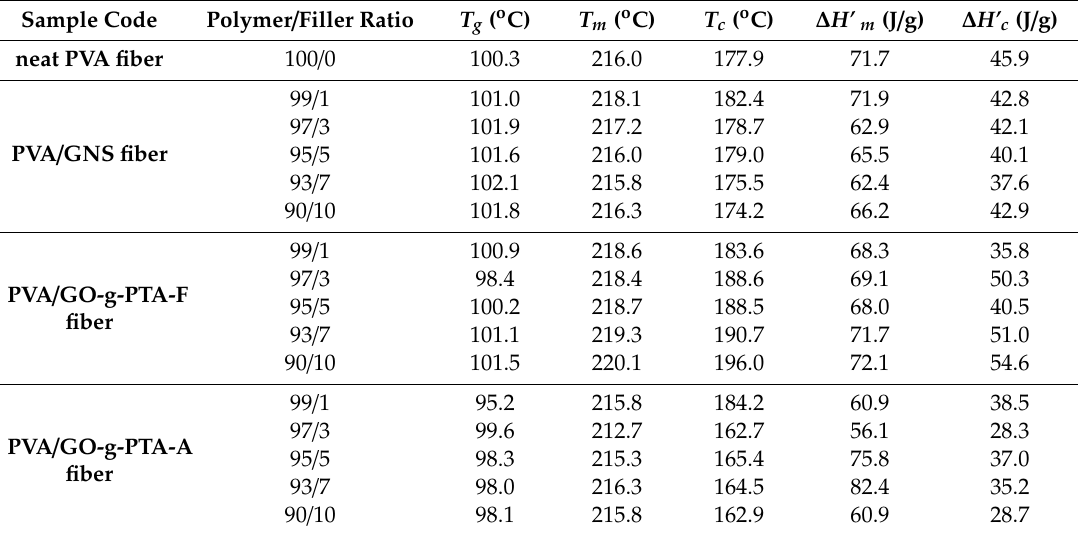
Table 2. Thermal properties of the PVA composite